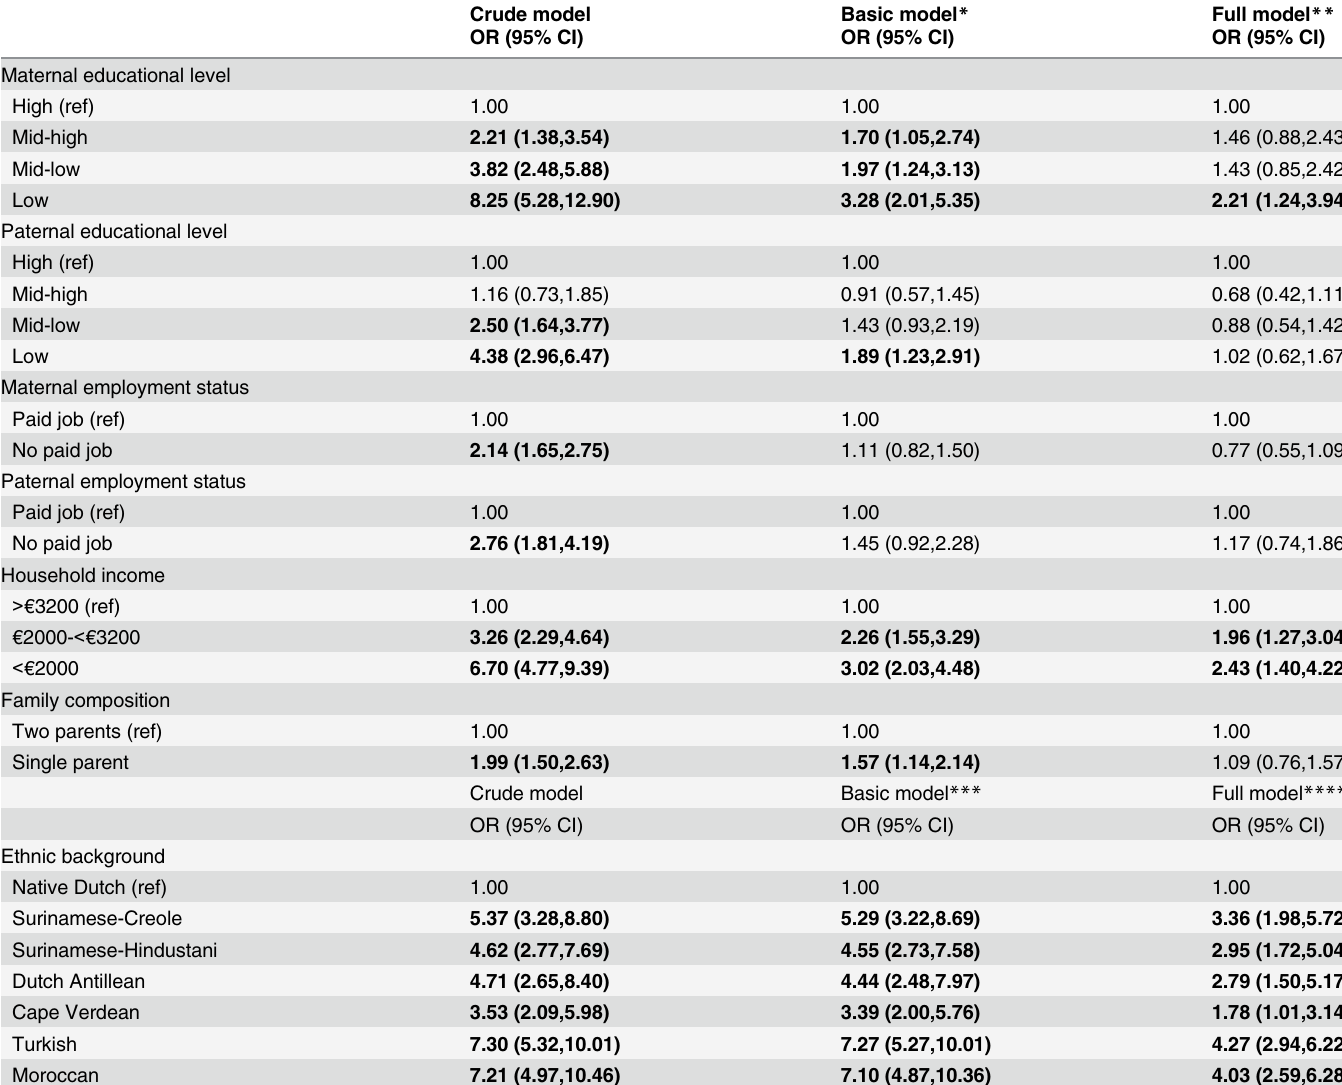
Table 3. Associations of family socioeconomic position and ethnic background with breakfast skipping at age 6 years (n = 4687).